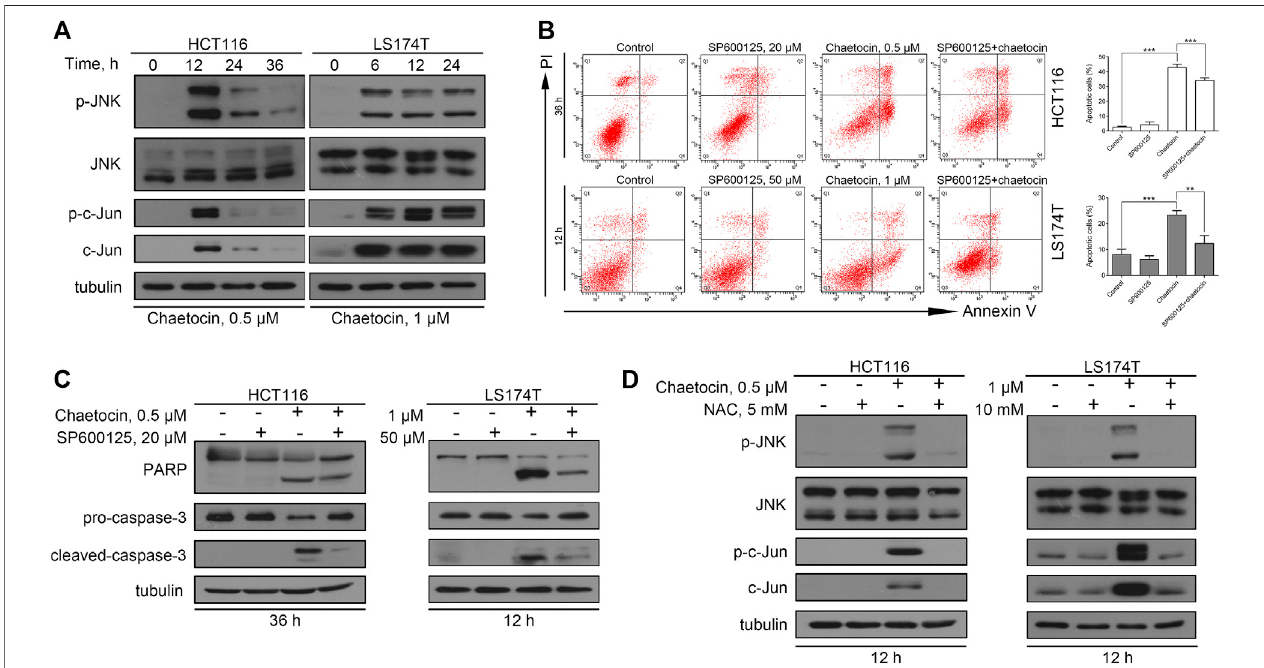
FIGURE 4 | The involvement of ROS/JNK/c-Jun in ROS-mediated cell apoptosis. (A) The protein level of JNK and c-Jun in HCT116 and LS174T cells after chaetocintreatmentbywesternblot.CRCcellswerepretreatedwithSP600125for2 hbeforechaetocintreatmentforindicatedhours. (B) Cellapoptosiswasmeasured by fl owcytometry. Resultswereshownasmean ± SDofthreeindependentexperiments.** p < 0.01,*** p < 0.001. (C) ExpressionofPARPandcaspase-3wasanalyzed bywesternblot. (D) TheexpressionlevelsofJNKandc-JunafterNACpretreatmentfor2 handthencotreatmentofchaetocinfor12 hinHCT116andLS174Tcells were analyzed by western